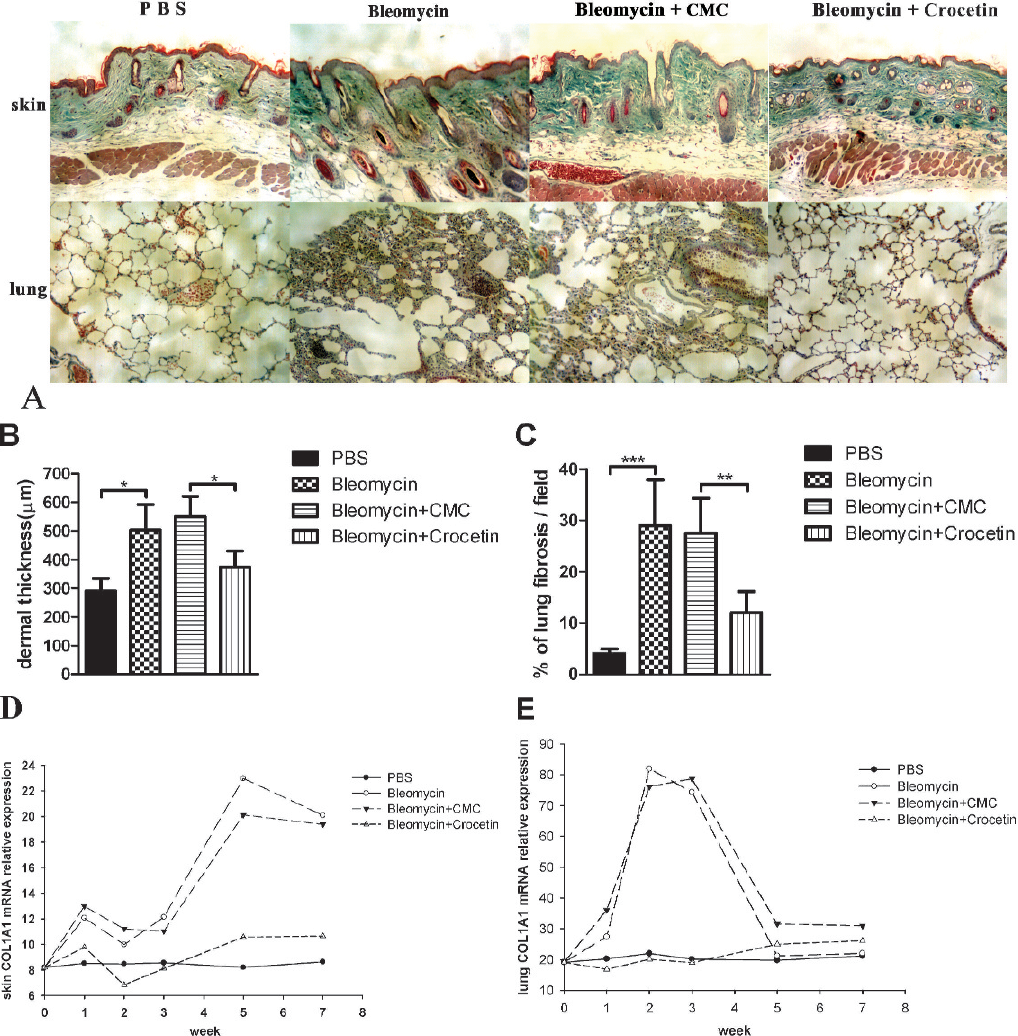
Figure 4 - Histological evaluation of mouse skin and lung tissues. (A) Representative pathologic findings from the skin and lung tissue from the mice at W3 after beginning the bleomycin or crocetin treatment; 6 100, Masson’s trichrome staining. (B) Dermal thickness (measured from the epidermal–dermal junction to the dermal–fat junction). (C) Percentage of lung fibrosis (evaluated by counting the numbers of pixels corresponding to stained collagen areas). (D) Skin COL1A1 mRNA levels; (E) Lung COL1A1